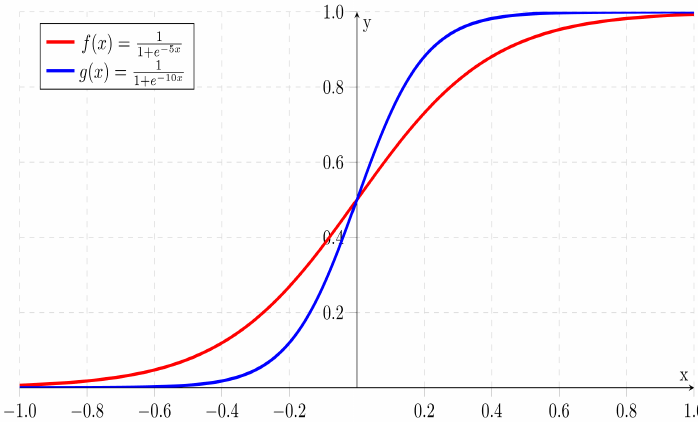
Figure 12. Sigmoid Activation